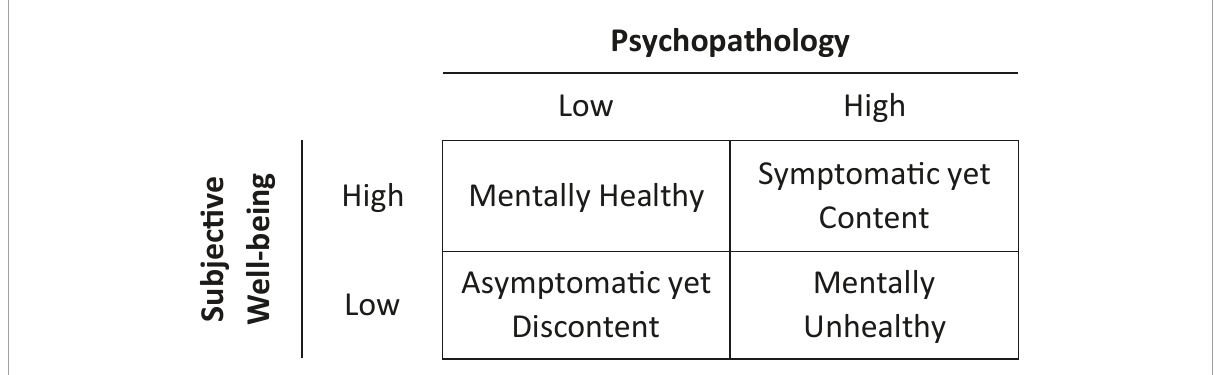
FIGURE1 Mental health status groups based on the Dual-factor Model of mental health (Greenspoon and Saklofske, 2001; Wang et al., 2011). The labels used in this study for the mental health groups come from Renshaw and Cohen (2014).